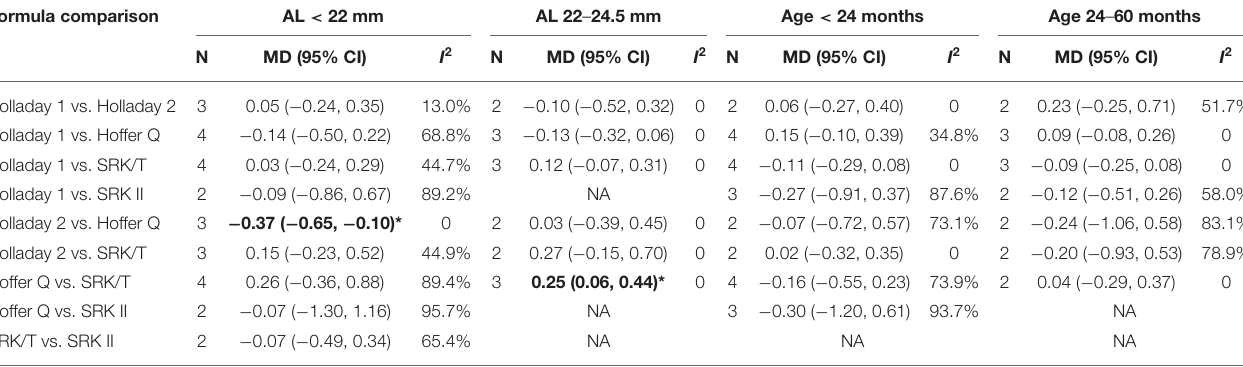
TABLE 3 | Mean difference of prediction error (PE) between groups stratified by age and axial length. Formula comparison